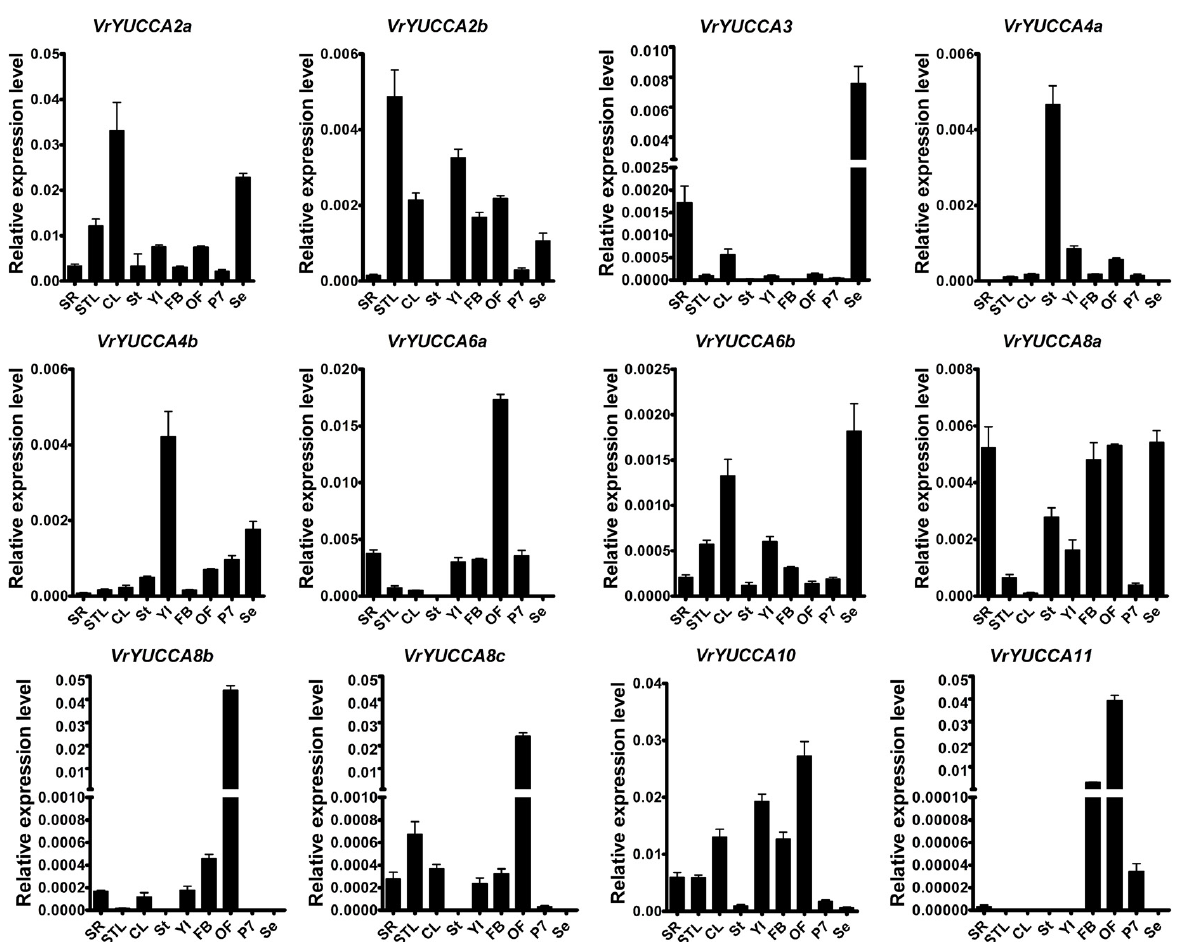
Figure 3. Expression pattern of VrYUCCAs in different tissues. SR, seeding root; STL, seedling true leaf; CL, compound leaf; St, stem; YI, young inflorescence; FB, flower bud; OF, opening flower; P7, 7-day pod; Se, seed. The VrACTIN3 gene ( Vradi03g00210 ) was used as the internal control to normalize the real-time PCR data. The 2 − ∆ CT method was used to analyze relative expression level. Error bars indicated SDs (standard deviations) from three biological repetitions.